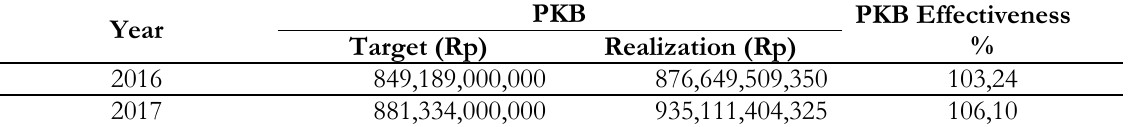
Acceptance of Motor vehicle tax of Bekasi City 2016-2017